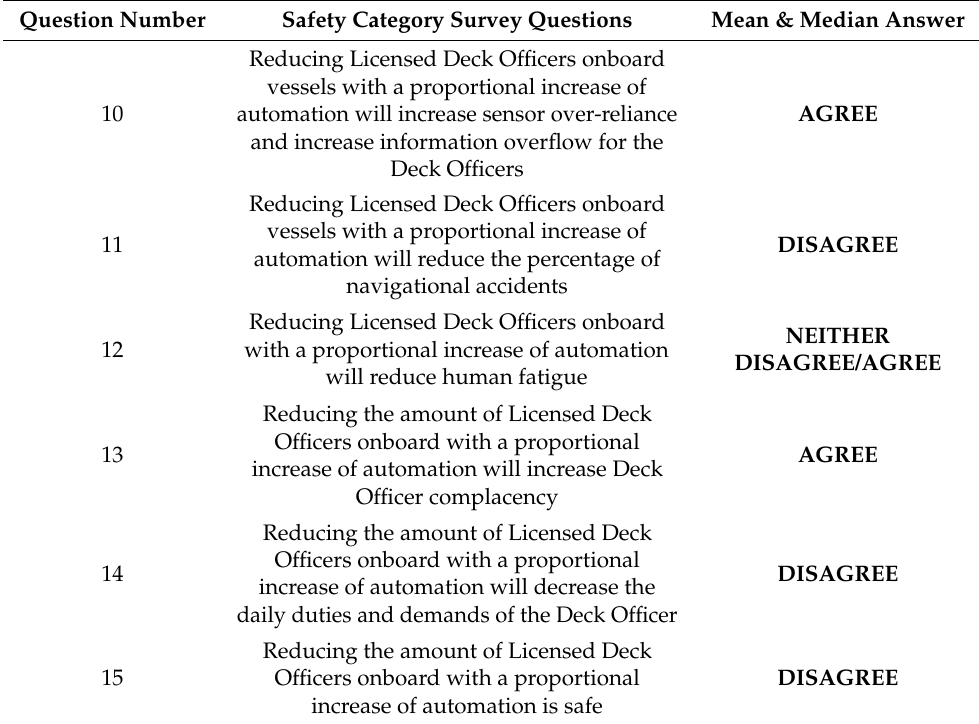
Table 2. Safety Category survey questions and response results.